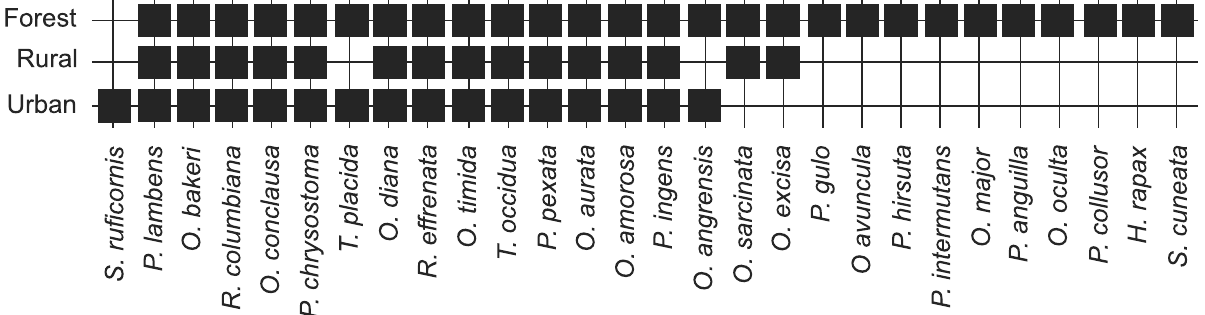
Figure 2. Serial analysis of distribution of species of Sarcophaginae in the Guajira province between habitats (Monte Carlo method with 30 random matrices =